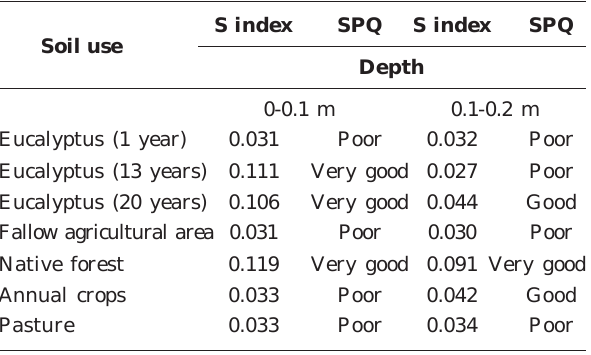
Table 4. The S index and soil physical quality (SPQ) for an Oxisol as a function of land use